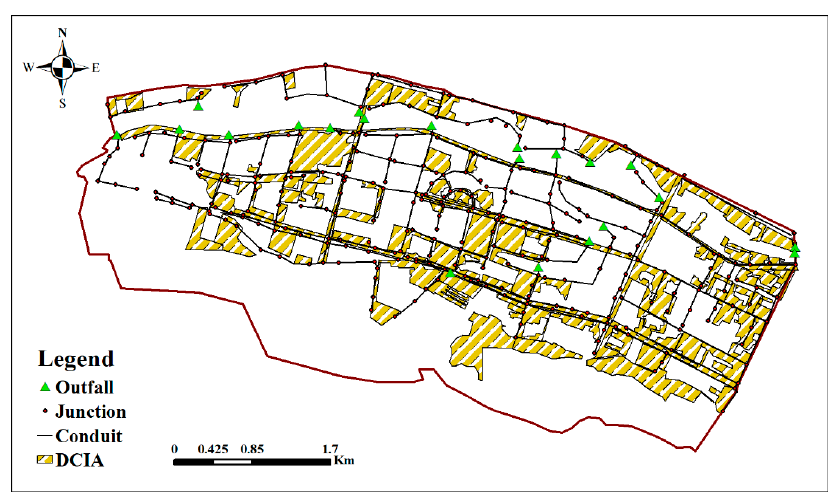
Figure 10. The distribution of directly connected impervious area within the study area.